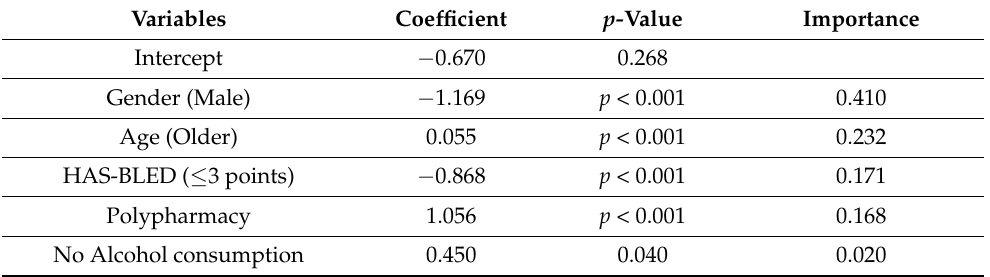
Table 3. Cross-tabulation of variables with CHADS2-VASC.